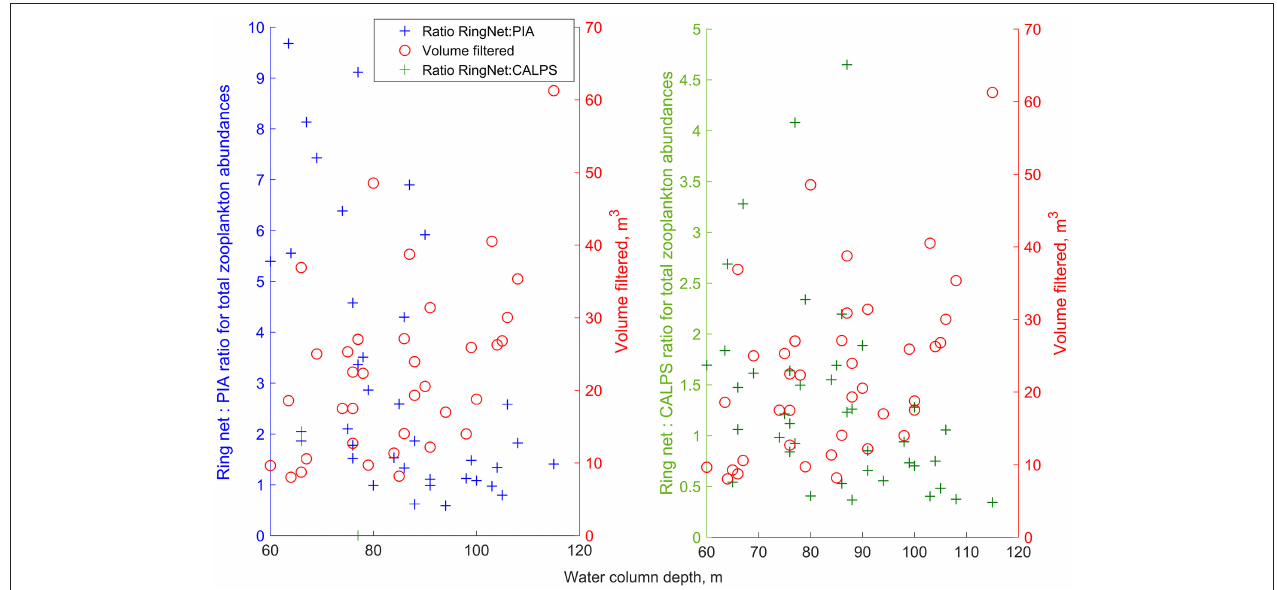
FIGURE 5 | RingNet:PIA and RingNet:CALPS ratios for the total abundance of zooplankton and volume filtered by the ring net as a function of depth of the water column sampled at all data points. Abundance ratios at each station were calculated as described in the Materials and methods part, and are available in the Supplementary Material.